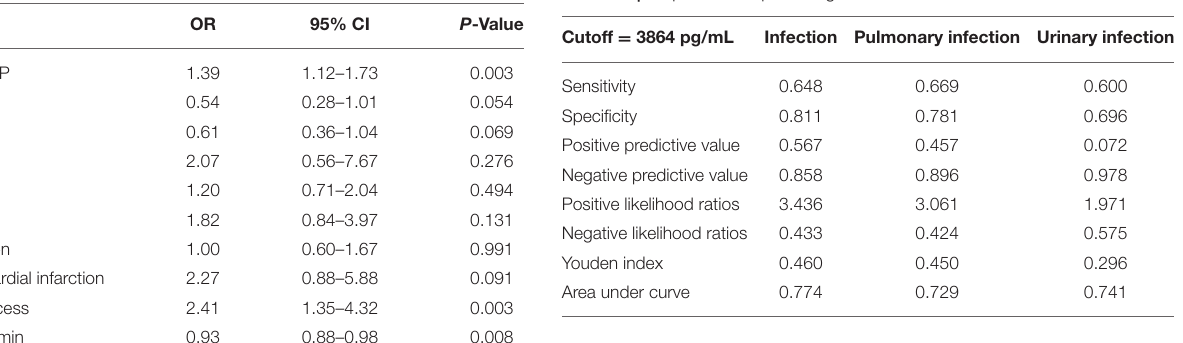
FIGURE 3 | The receiver operating characteristic curve of N-terminal probrain natriuretic peptide (NT-proBNP) for infection. TABLE 3 | NT-proBNP for predicting